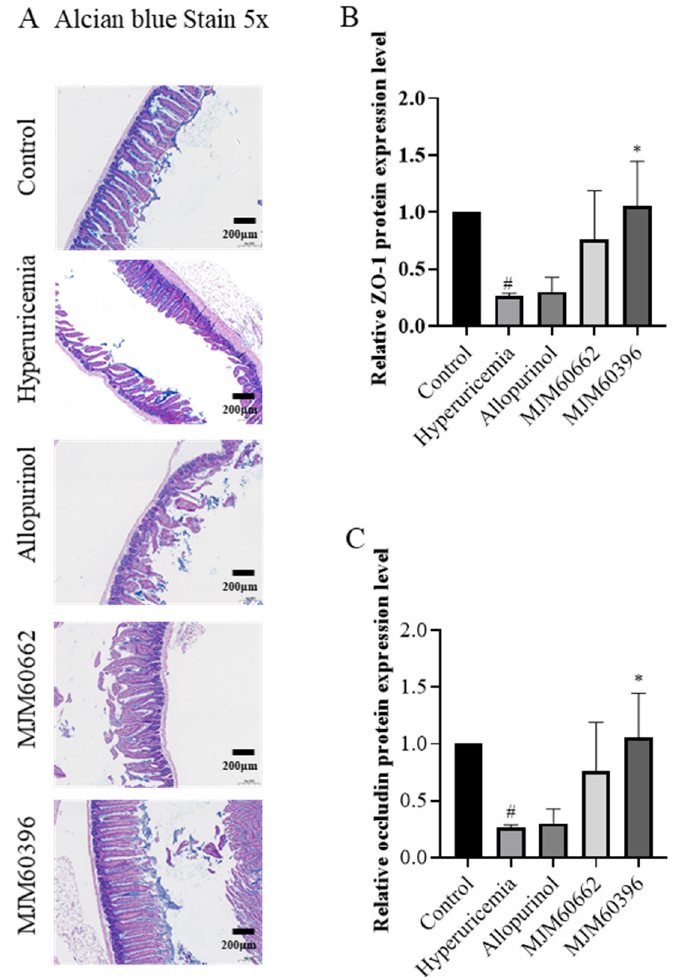
Figure 6. Intestine alcian blue staining and expression of tight junction proteins in the intestine. ( A ) Effect of MJM60396, MJM60662 strain, and allopurinol on intestine histopathology of hyperuricemia mice at a magnification of 5 × alcian blue staining. ( B ) Protein expression levels of intestine ZO-1 were analyzed by ELISA. ( C ) Protein expression levels of intestine occludin were analyzed by ELISA. # p < 0.05 compare with control group. * p < 0.05 compared with hyperuricemia group. Scale bar: magnification of 5× = 200 µm The protein expression levels of ZO-1 in the intestinal tissues were downregulated in the hyperuricemia, allopurinol, and MJM60662 groups compared with the control as deter-